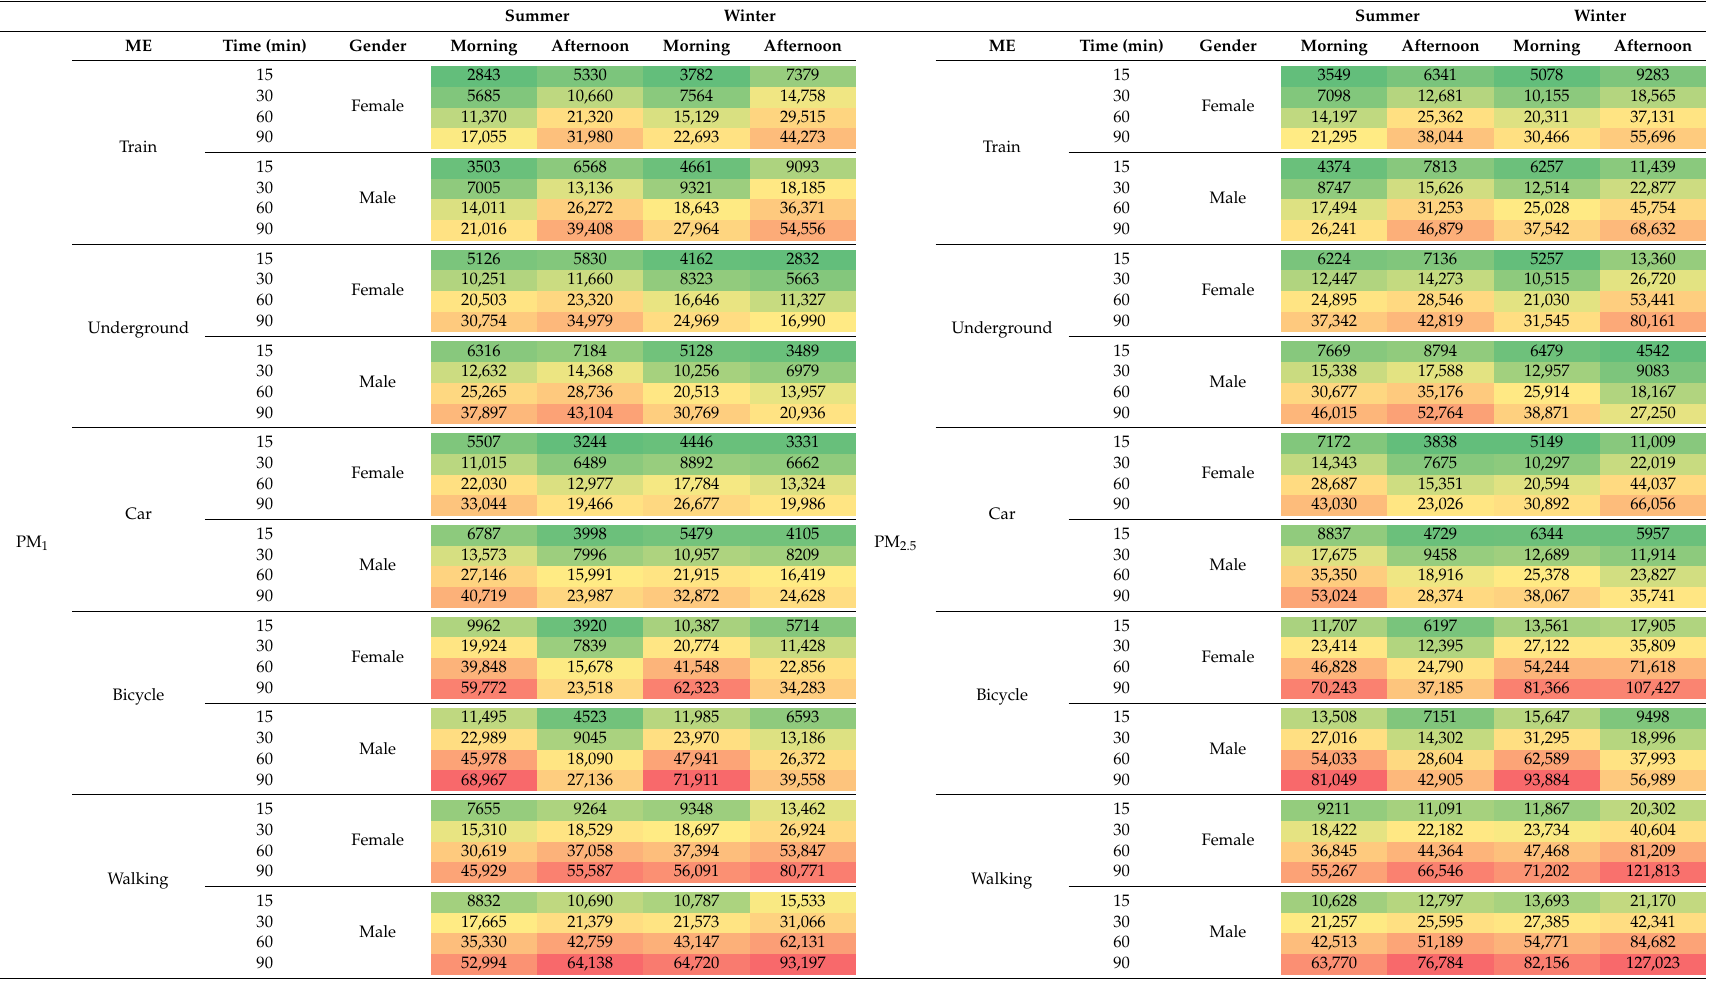
Table 4. Estimated values of the inhaled dose ( µ g) for the di ff erent fractions of PM, divided by the ME considered, time spent commuting, gender, and monitoring period. The colors qualitatively indicate the increase in the doses of inhaled pollutants (from green—lower inhaled doses, to red—higher inhaled doses). Summer Winter Summer Winter